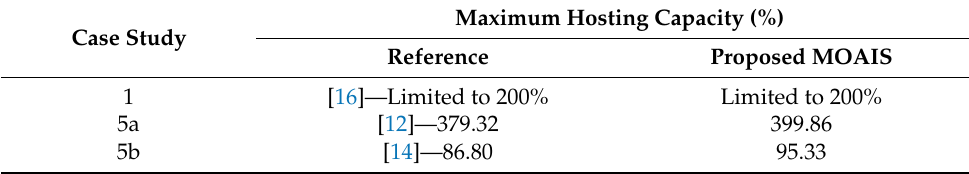
Table 13. Comparative analysis of maximum HC (Literature ×